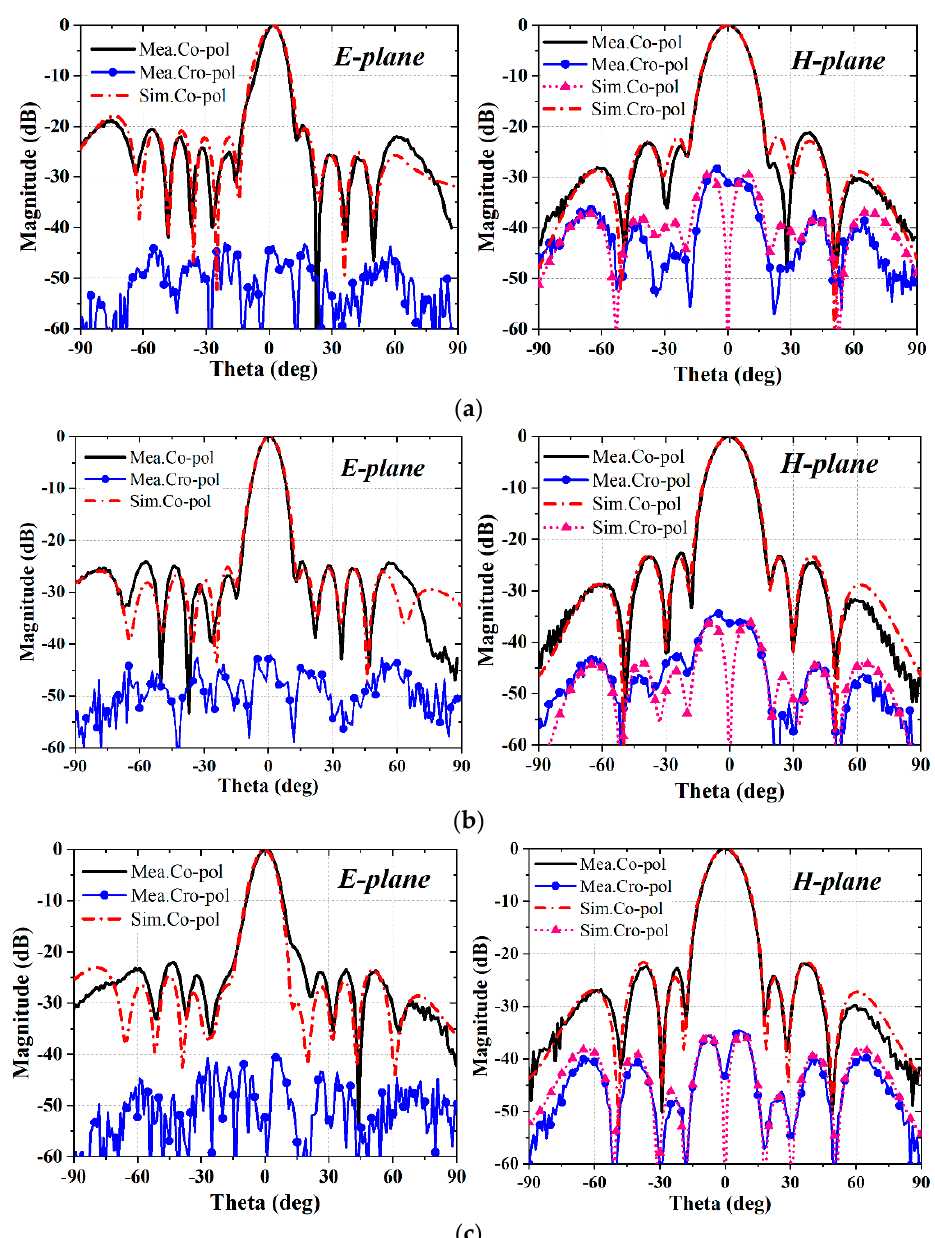
Figure 17. The simulated radiation patterns of the proposed low SLL planar array at ( a ) 78 GHz, ( b ) 79 GHz, and ( c ) 80 GHz.